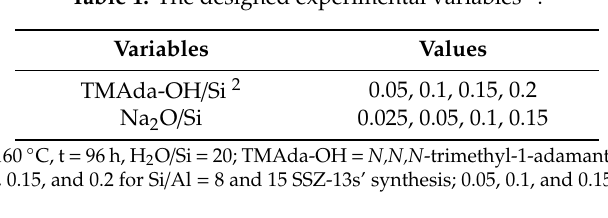
Table 1. The designed experimental variables 1 .